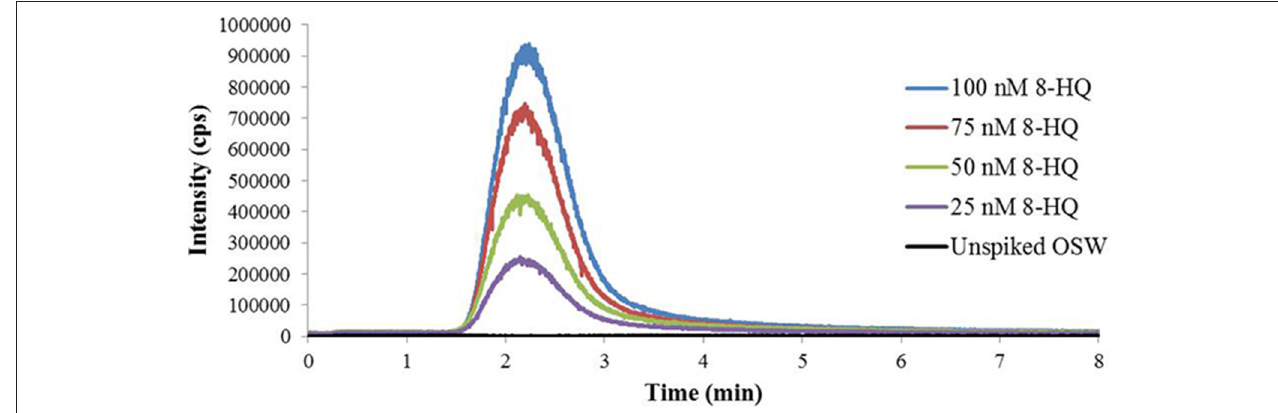
FIGURE 3 | Multiple reaction monitoring (MRM) chromatograms for the m/z 146.2 > 91.2 transition used to quantify the model ligand 8-hydroxyquinoline (8-HQ) in Cu(II)-IMAC fractions desalted by solid-phase extraction (SPE). The fractions correspond to the model ligand peaks observed in the Cu(II)-IMAC chromatogram obtained by fractionating 1-L surface seawater samples spiked with 0–100 nmoles 8-HQ. Ten microliter of each SPE extract were analyzed by flow-injection electrospray ionization tandem mass spectrometry (FI-ESI-MS/MS) using 1mM ammonium acetate in 70% acetonitrile at 100 µ L/min as the carrier